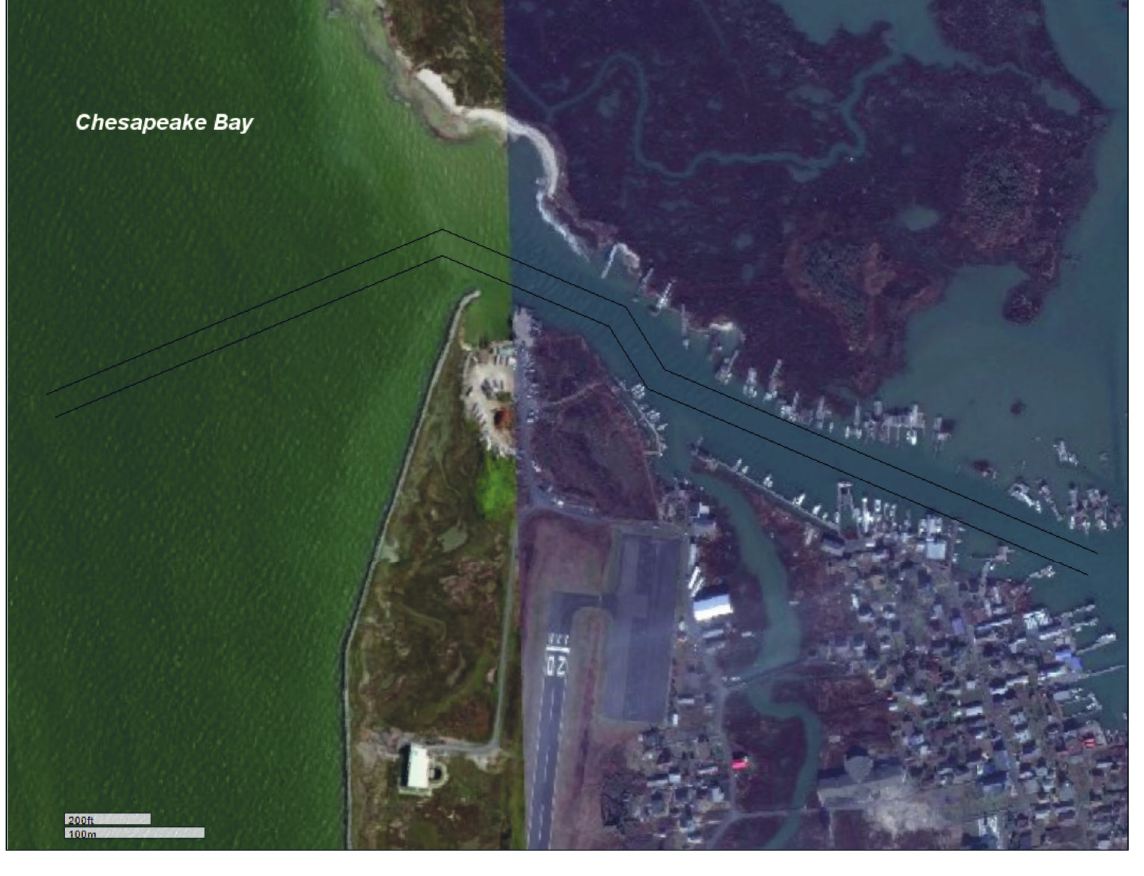
Figure 4. Western part of Tangier Island boat